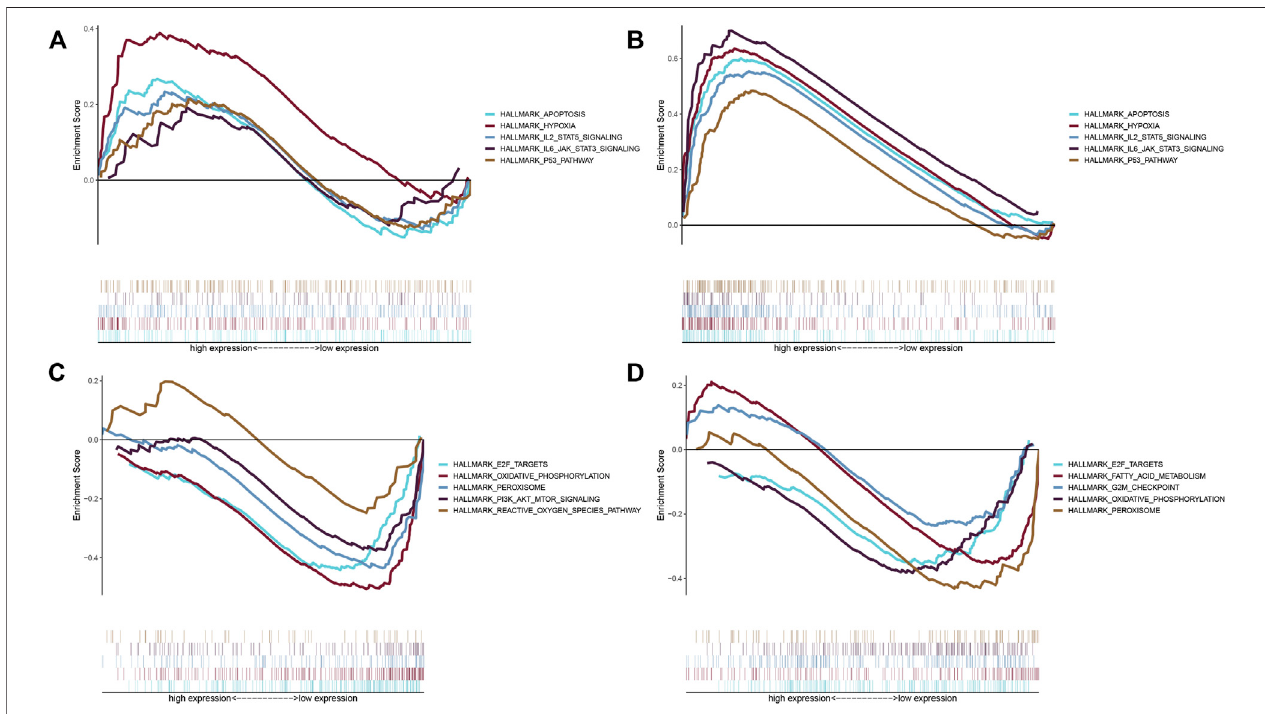
FIGURE5 | Enrichmentof pathways in the high-risk and low-riskgroups. (A) Enriched genesets inthe hallmark gene collection by the high-risk score inthe TCGA database. The lines with different colors represent different gene sets. The up-regulated genes are located near the origin of the coordinate on the left, while the down- regulated genes are located on the right side of the x -axis. Gene sets with NOM p < 0.05 and FDR q < 0.06 were statistically signi fi cant. Only a few major gene sets are shown. (B) Enriched gene sets in the hallmark collection by the high-risk score in the GEO database. Gene sets with NOM p < 0.05 and FDR q < 0.06 were statistically signi fi cant. Only a few major gene sets are shown. (C) Enriched gene sets in the hallmark collection by the low-risk score in the TCGA database. Only gene sets with NOM p < 0.05 and FDR q < 0.06 were considered statistically signi fi cant. Only a few major gene sets are shown. (D) Enriched gene sets in the hallmark collectionbythelow-riskscoreintheGEOdatabase.GenesetswithNOM p < 0.05andFDR q < 0.06werestatisticallysigni fi